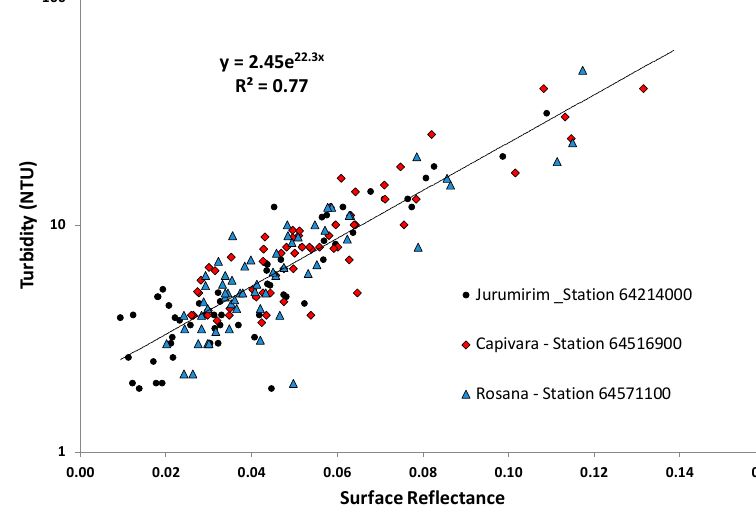
Figure 3. Turbidity as a function of the surface reflectance in the red wavelength range. The points represent consistency between the field turbidity measurements and MODIS data between 2000 and 2012 for three different locations along the Paranapanema River.